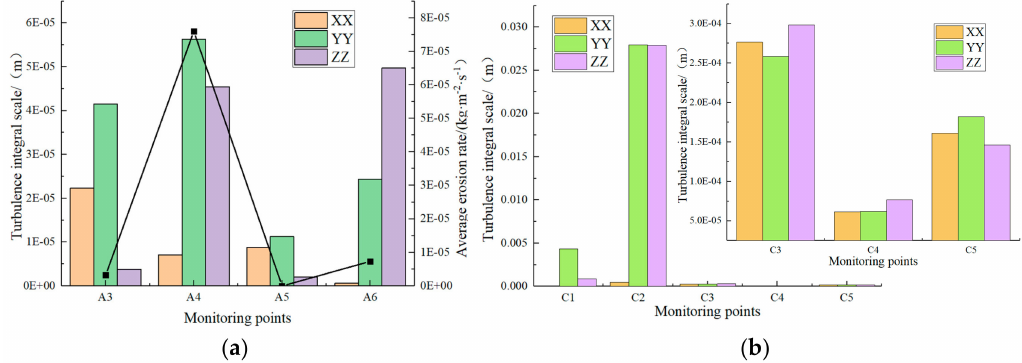
Figure 14. Turbulence integral scale: ( a ) Turbulence integral scale and average erosion rate of A3–A6; and ( b )